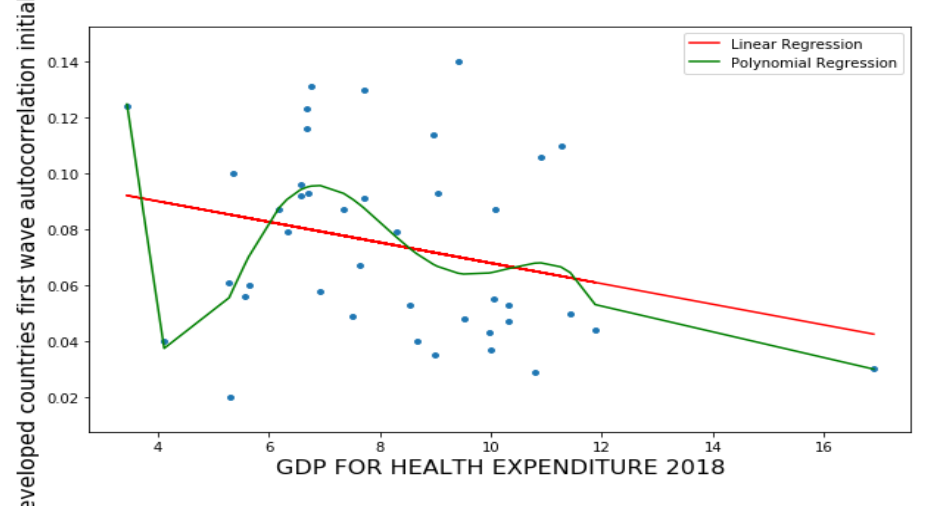
Figure 3. Linear (in red) and sextic (in green) regression plots of first wave opposite of initial auto- correlation slope vs CHE/GDP. LinregressResult slope = 0.01117, intercept = 0.0664, r value = 0.47219, p value = 0.0097, stderr = 0.004, RMSE for linear regression = 0.0387, RMSE for polynomial regression = 0.04399, R-squared for order six polynomial regression = 0.4.